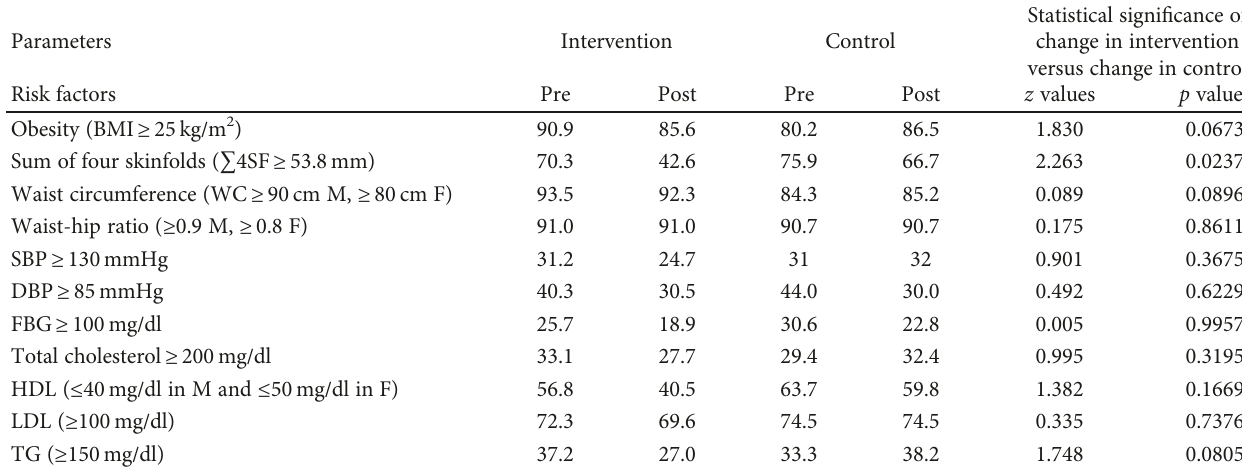
Table 5: Changes in abnormal pro fi le of various factors to normal after intervention.